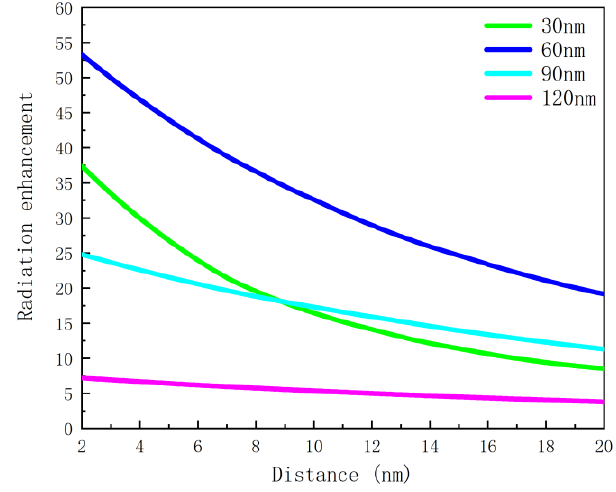
Figure 9. Radiation enhancement as a function of distance at 650 nm emission wavelength.